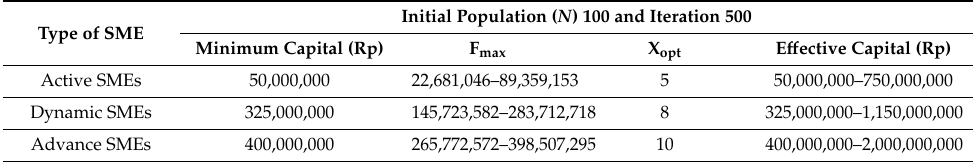
Table 4. Result of data analysis when using